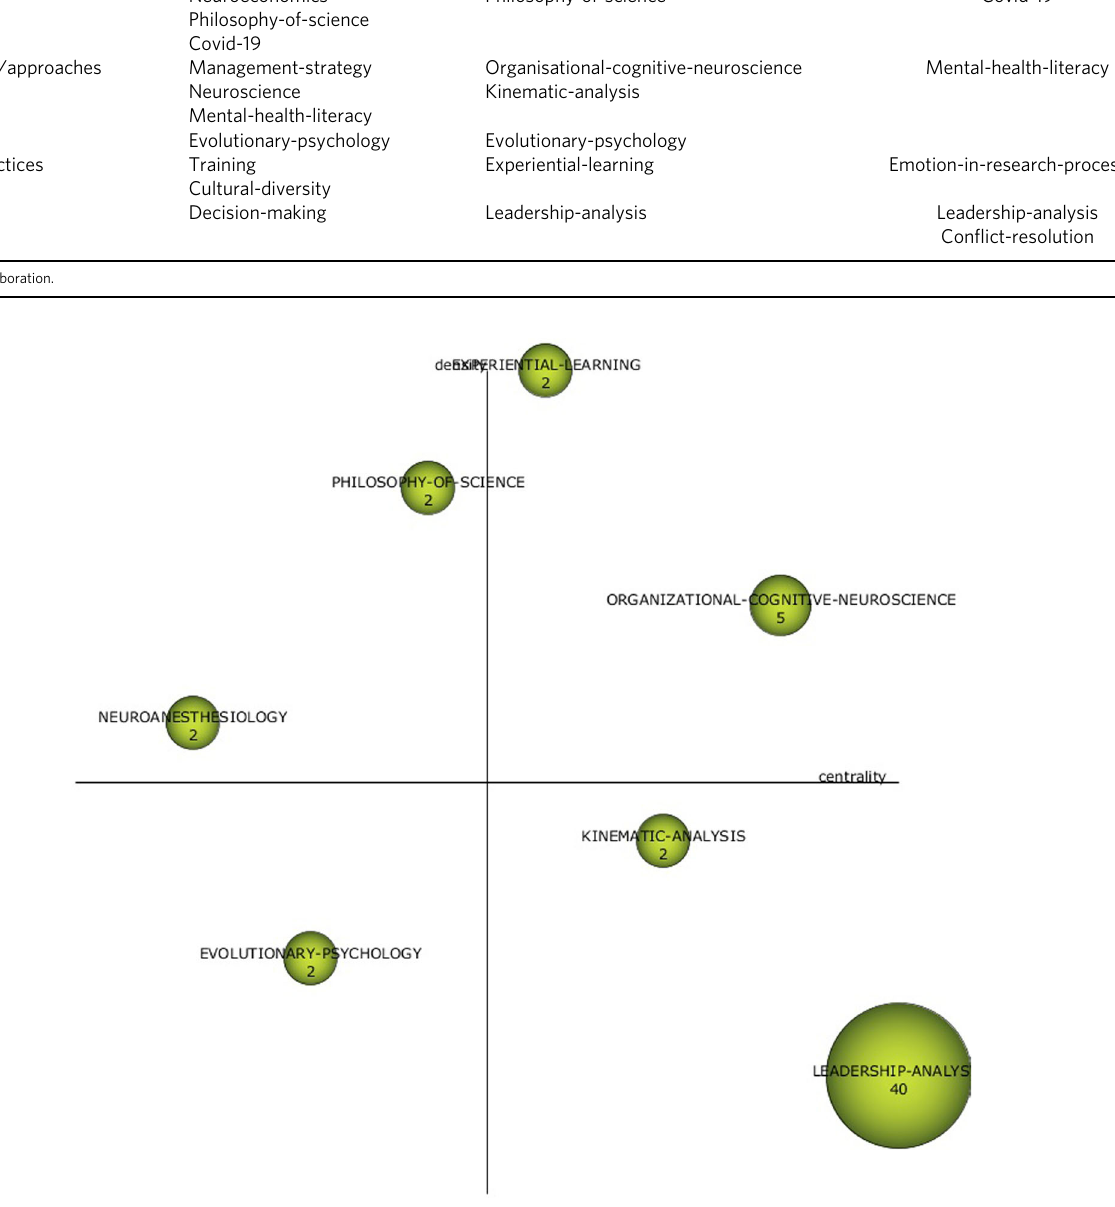
Fig. 5 Strategy diagrams by pre-pandemic (1992 – 2019) period. Results from SciMat, diagram composed of themes by number of documents for (1992 –